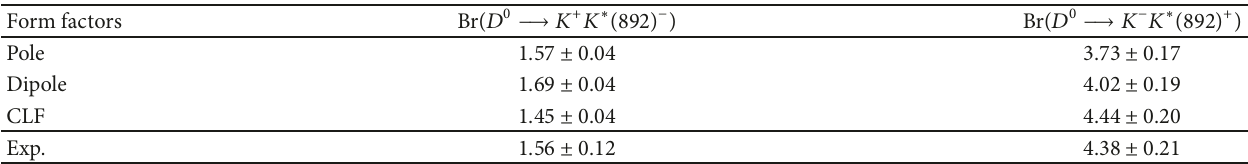
Table 1: The magnitude of tree and penguin contributions (in unit of 10 −3 ) corresponding to the topological amplitudes in (19) and (20). The factors “ (𝐺 𝐹 /√2)𝜆 𝑠 (𝜀 ∗ ⋅ 𝑝 𝐷 ) ” and “ −(𝐺 𝐹 /√2)𝜆 𝑏 (𝜀 ∗ ⋅ 𝑝 𝐷 ) ” are omitted in this table. Decay modes 𝑇 𝐾 ∗− 𝐸 𝑢 𝐾 + 𝑃𝑇 𝐾 ∗− 𝑃𝐸 𝑠 𝐾 ∗− 𝑃𝐸 𝑢 𝐾 + 𝐷 0 󳨀→ 𝐾 + 𝐾 ∗ (892) − 0.23 −0.02 + 0.15 i